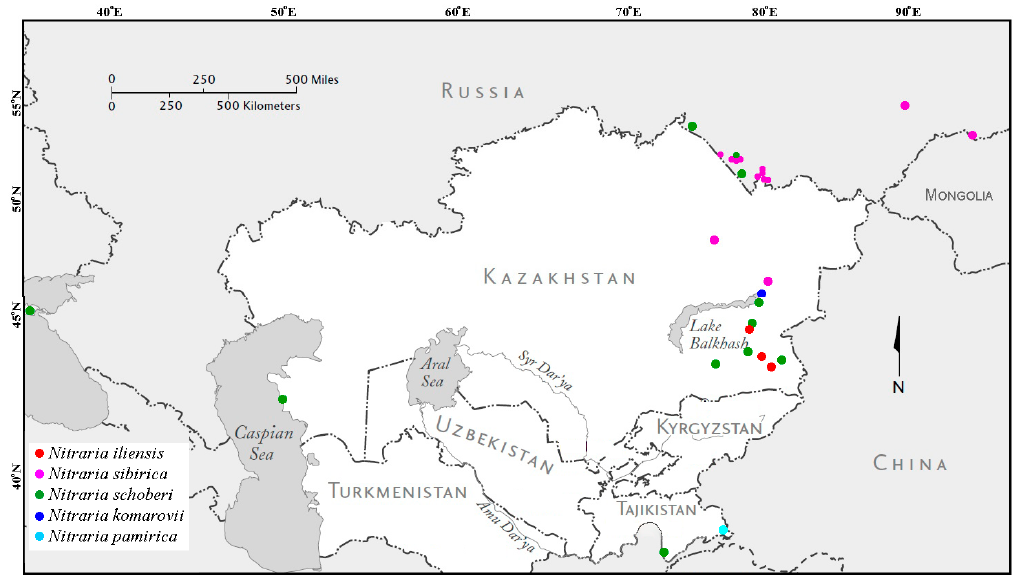
Figure 10. Distribution map of research specimens of the genus Nitraria . The collectors of all the samples indicated on the map are Banaev E.V. and Tomoshevich M.A.